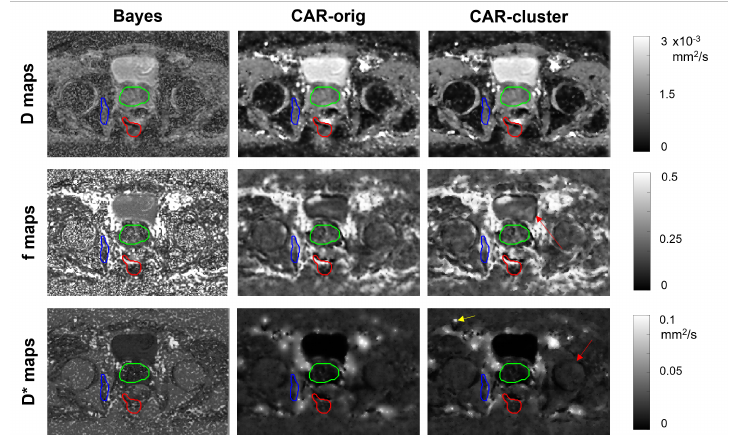
Figure 6. Parametric maps of D ( first row ), f ( second row ) and D ∗ ( third row ), estimated from a selected slice of a pelvic patient using the three methods (columns). The tumor, the prostate and the internal obturator muscle are delineated in red, green and blue, respectively. Red arrows indicate improvement in boundary definition, yellow arrows indicate reduced blurred effects. Table 1. Values of D , f and D ∗ estimated from the real images in each structure of interest by the three methods, reported in terms of mean and standard deviation over the